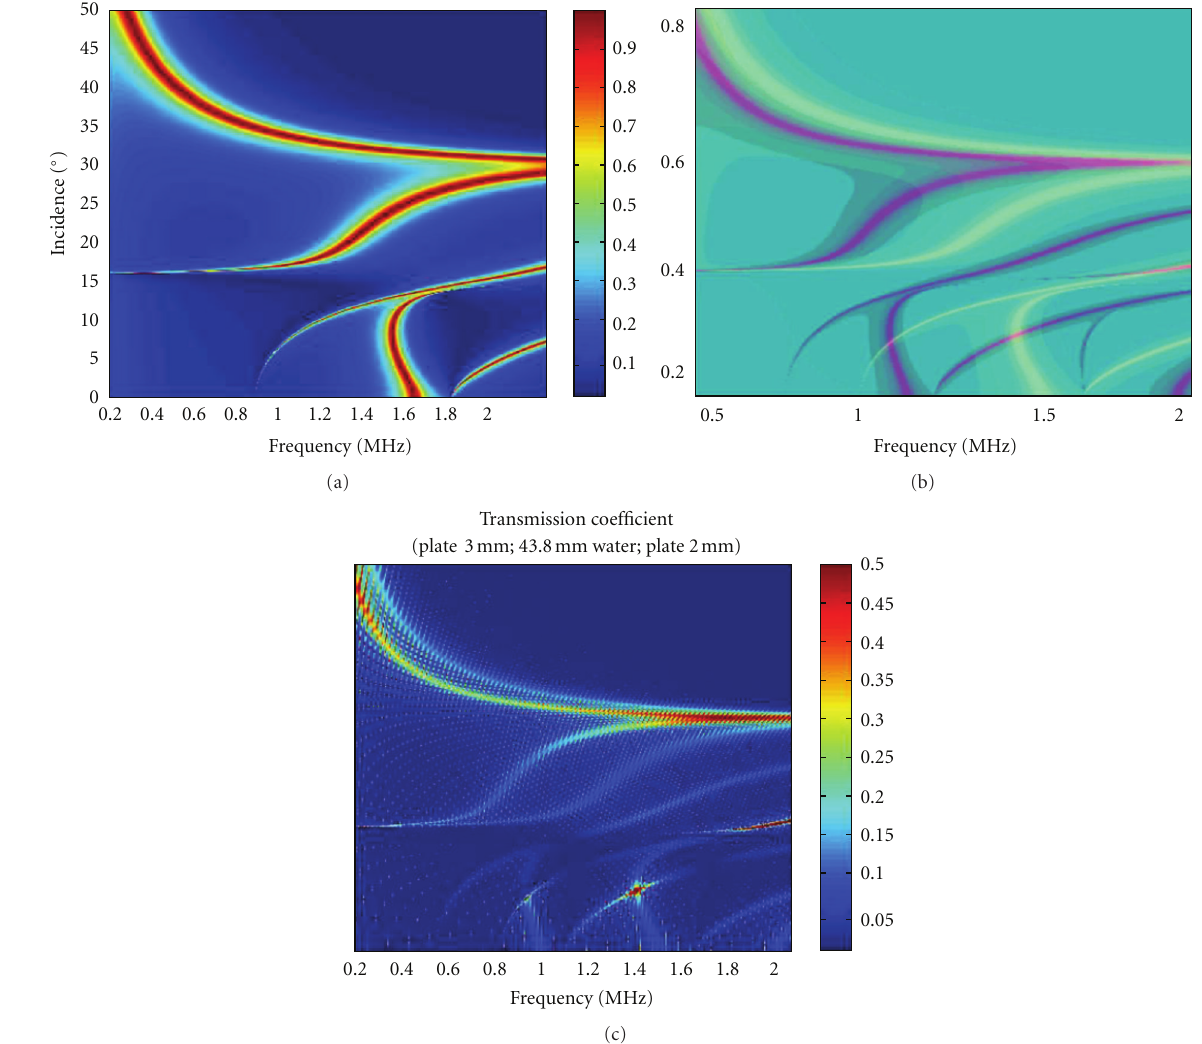
Figure 21: Transmission coe ffi cients calculated for di ff erent systems: (a) a single 2mm thick plate: Lamb wave modes appear very clearly, (b) graphical superposition for a single 2mm thick plate and for a 3mm thick plate: each plate has its own Lamb wave modes, (c) two plates (2mm thick and 3mm thick): there is a global Lamb wave mode filtering.